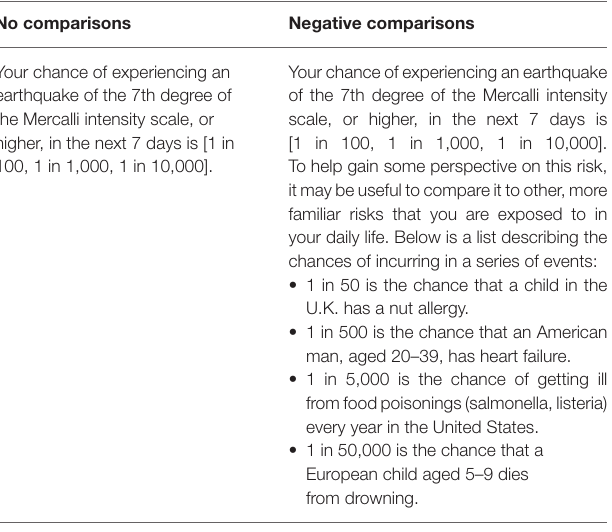
TABLE 1 | Information provided to participants in the two experimental conditions. No comparisons Negative